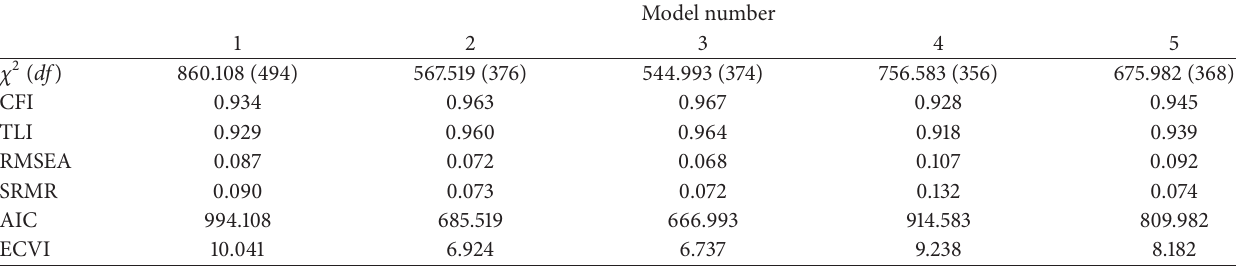
Table 2: Model comparisons.